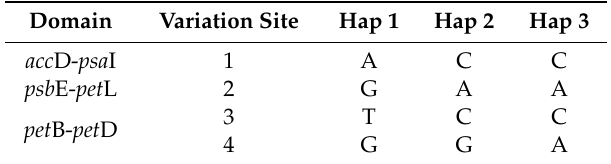
Table 7. The variations in acc D- psa I, psb E- pet L and pet B- pet D regions among 80 accessions.